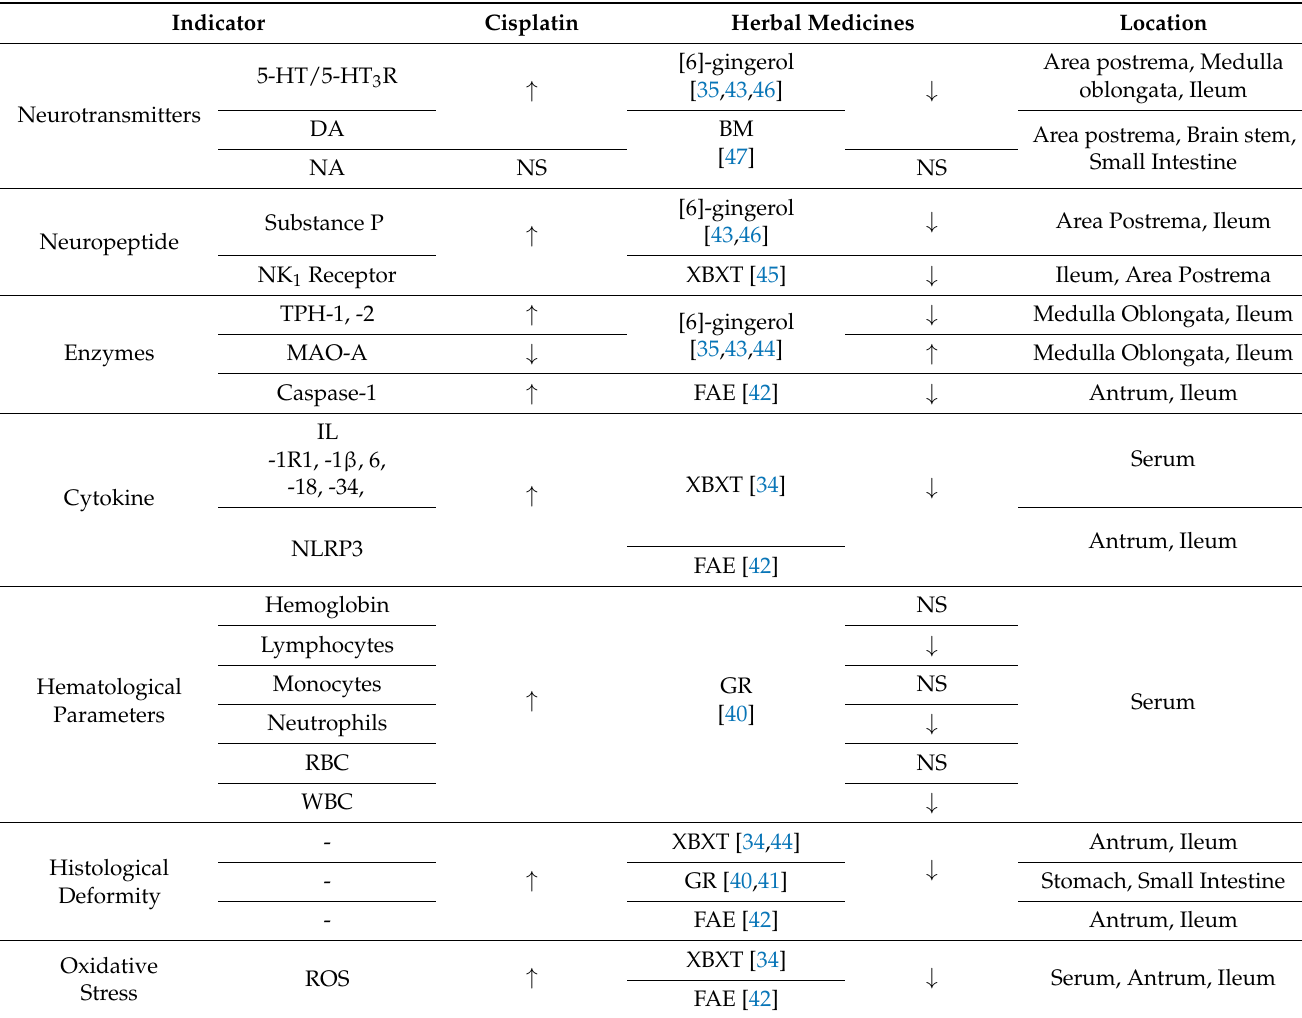
Table 3. Mechanisms of Action of Herbal